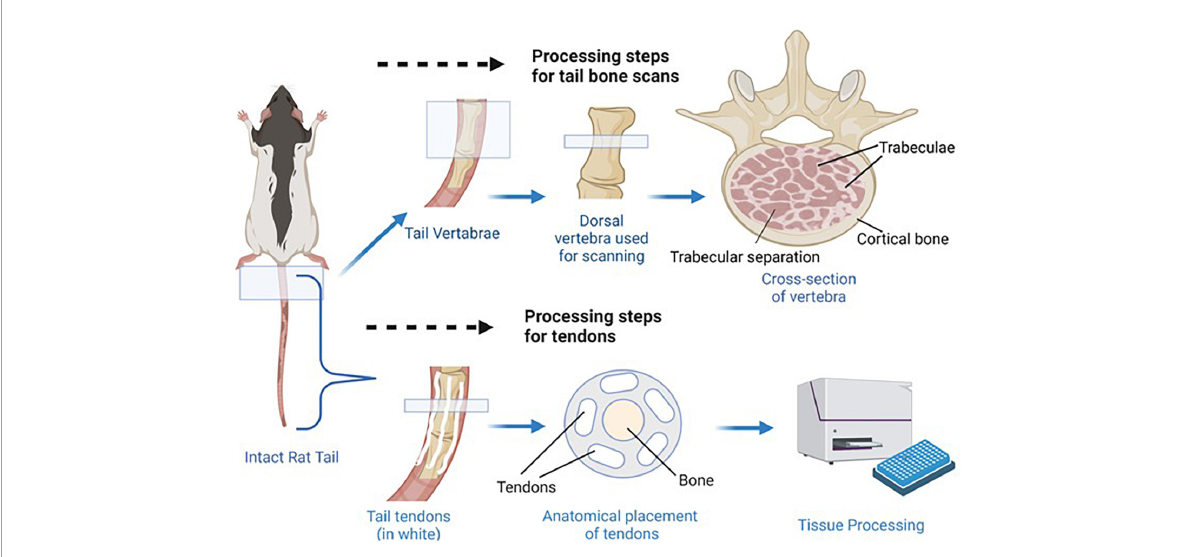
FIGURE3 Bone and tendon tissue retrieval. Shown above , the most dorsal vertebra of each tail was dissected so that micro CT scans could be used to determine trabecular separation, bone volume fraction, and connectivity density. Anatomical placement of trabecular separation areas, trabeculae, and cortical bone is indicated in the cross section image. Shown below , the tendons were dissected from the tails so collagen concentrations could be determined as a measure of tendon health/development. Anatomical placement of tendons and vertebra bone tissue is shown in the tail cross